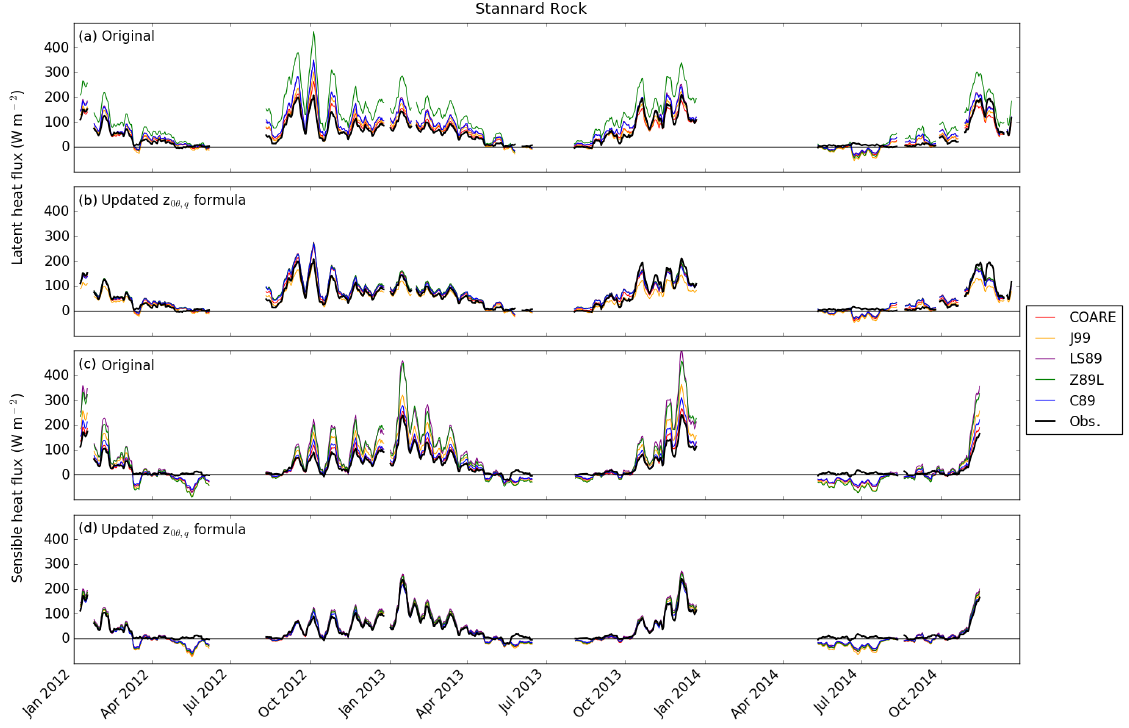
Figure 4. Running mean time series (10 days) of latent ( λE ) and sensible ( H ) heat fluxes at Stannard Rock. Black lines denote observed λE and H and denote the same for (a–d) . The λE and H simulations employ the original z 0 θ,q formula in (a) and (c) and with the updated z 0 θ,q formula in (b) and (d) . The COARE simulation results are unchanged from (a) to (b) or from (c) to (d)